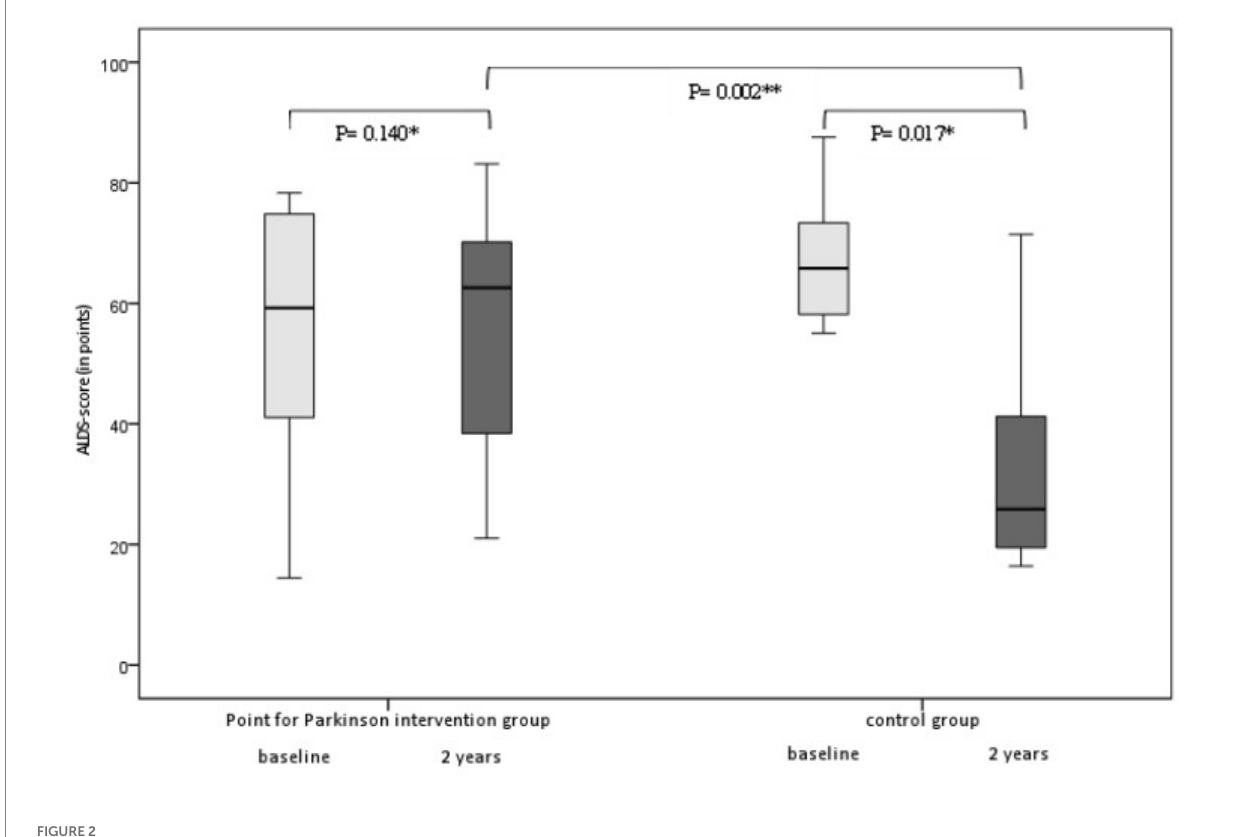
FIGURE 2 Box plots of median changes in primary outcome (ALDS scores/min-max range) between the intervention group and the control group at baseline (between group differences at 2 years p = 0.002 95% CI). *Wilcoxon, **Mann–Whitney U